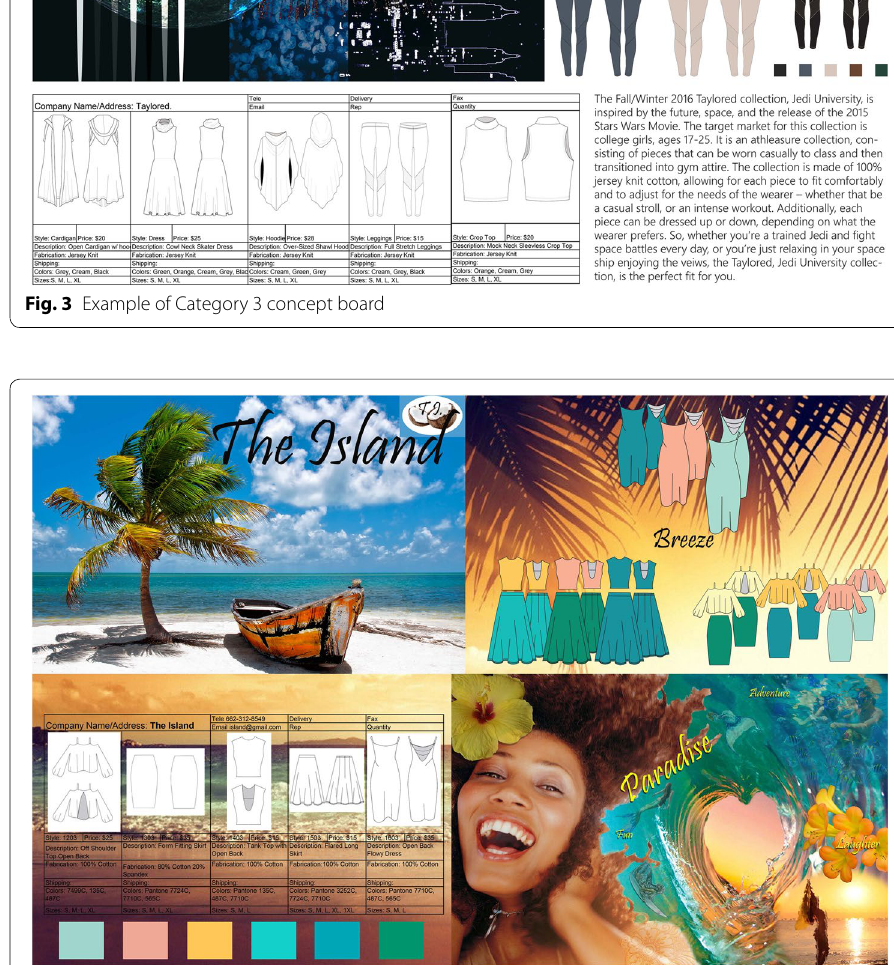
Fig. 4 Example of Category 4 concept